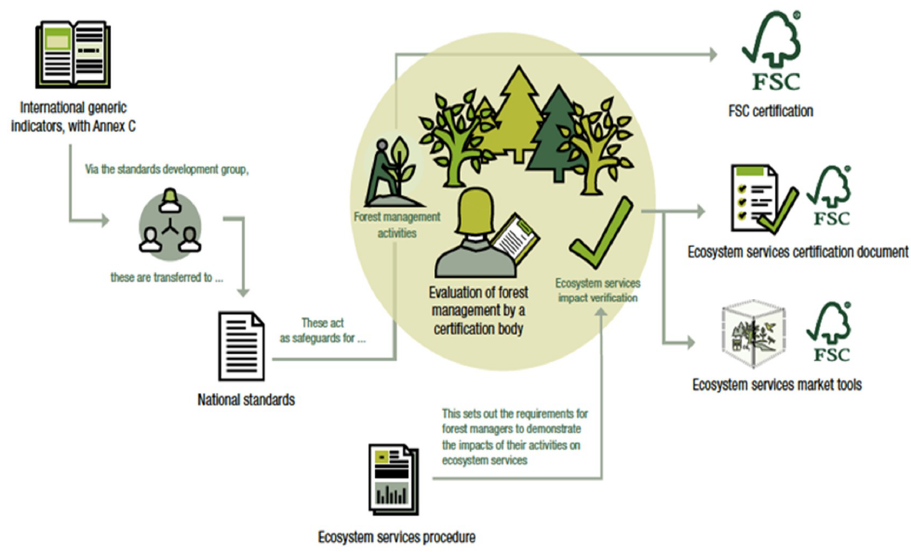
Figure 3. The envisaged FSC Ecosystem services certification process when the research